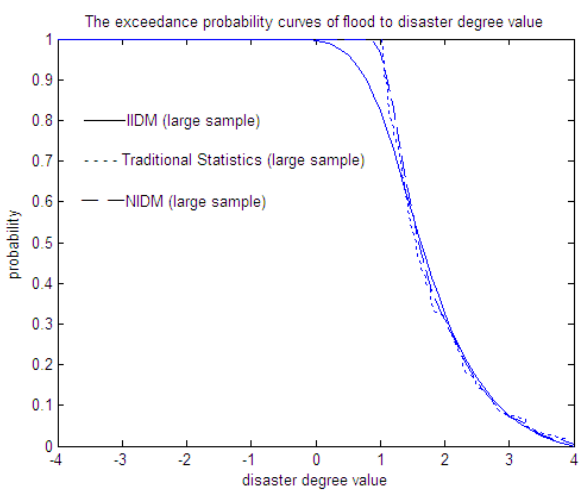
Fig. 3 comparisons of the risks by IIDM, the traditional statistical method, and NIDM 685